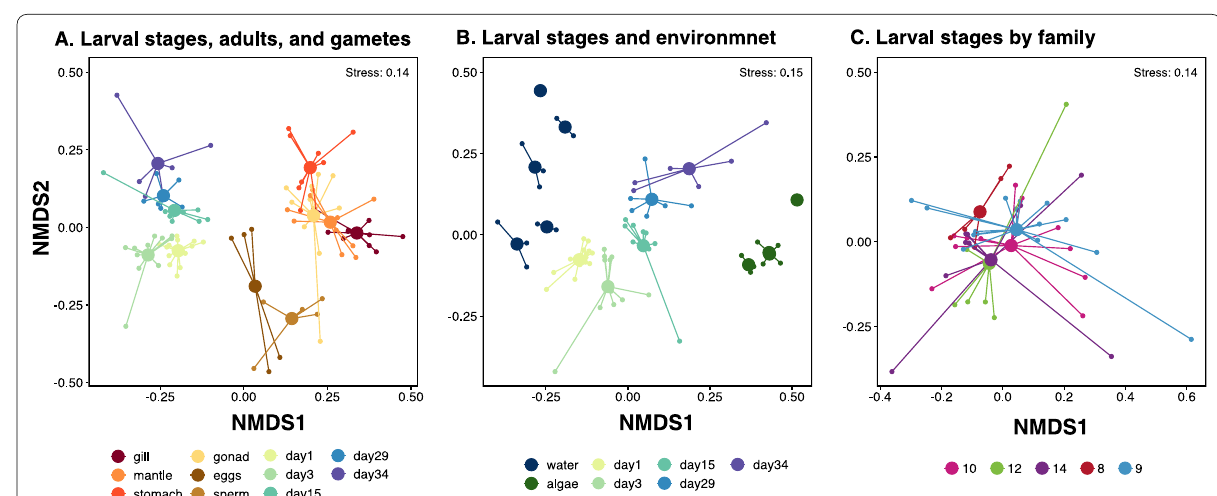
Fig. 2 Non‑metric multidimensional scaling (NMDS) plots of Sorensen‑Dice dissimilarities of microbial communities associated with oyster larvae, gametes, and their environment. Colored by A larval stage day, adult tissues and gametes, B larvae stage day and environment, and C family. Group centroids are defined by the mean dissimilarities for each